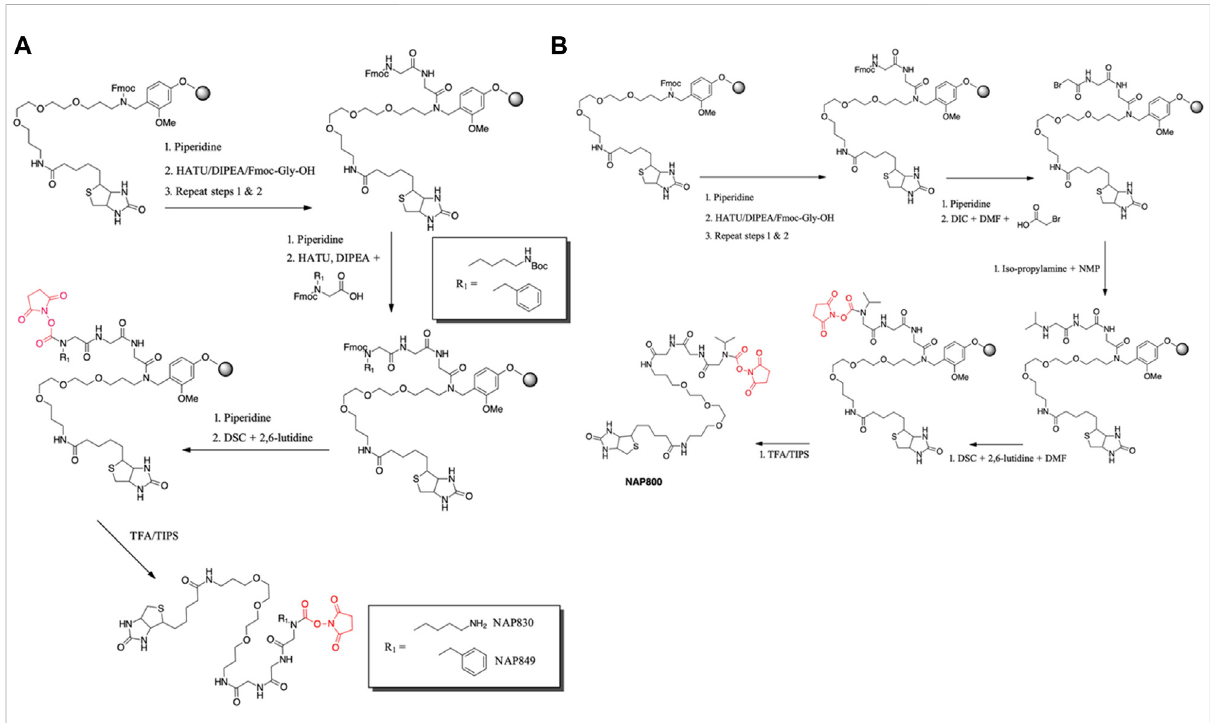
FIGURE 3 Solid phase synthesis approaches, used in the present study, for the preparation of N-alkyl glycine N-hydroxy succinimidyl carbamates. (A) NAP849 andNAP830. (B)